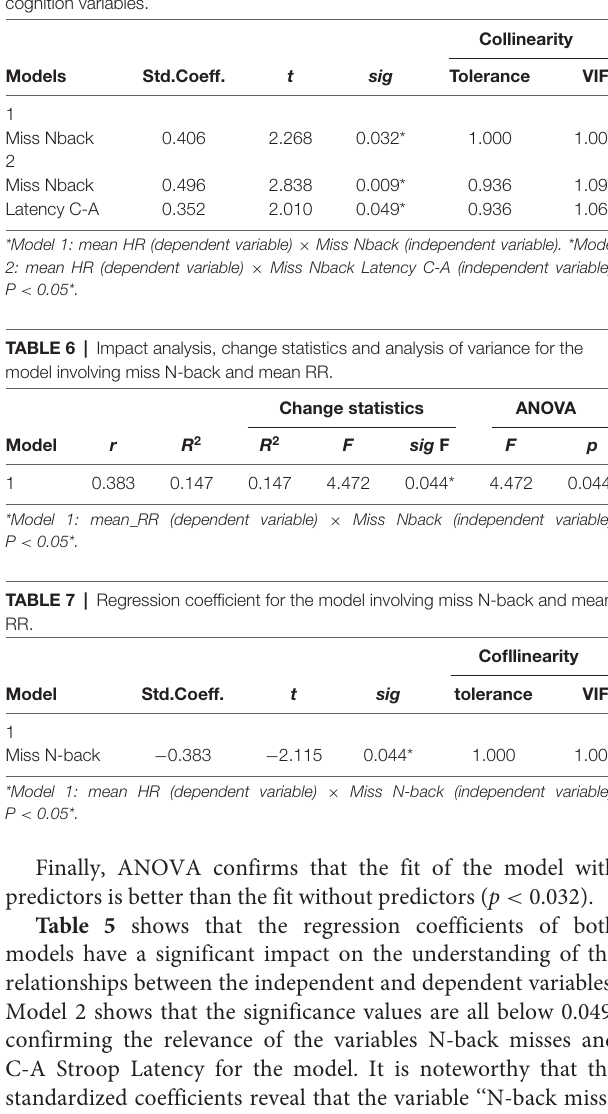
TABLE 5 | Regression coefficient for models involving mean HR variability and cognition variables.